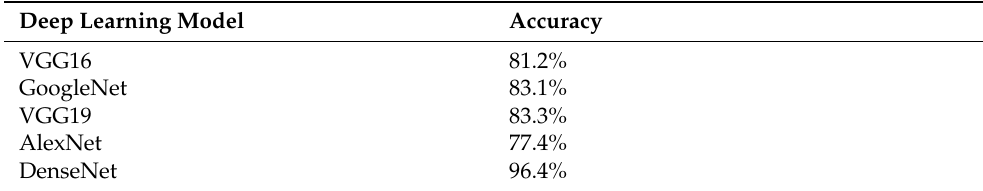
Table 1. Experimental results with different pre-trained models on siRNA dataset.